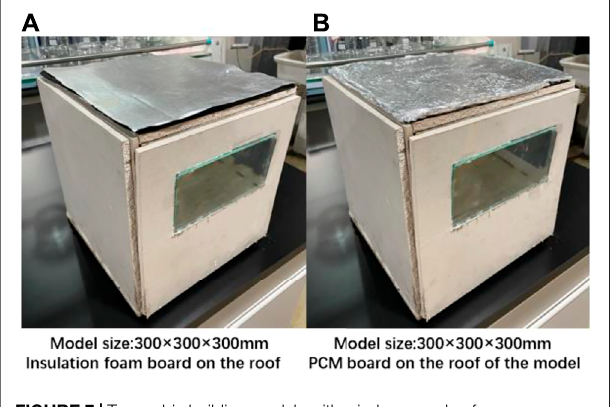
FIGURE 7 | Two cubic building models with windows made of gypsum board: (A) with insulation foam on the roof, (B) with PCM board on the roof.